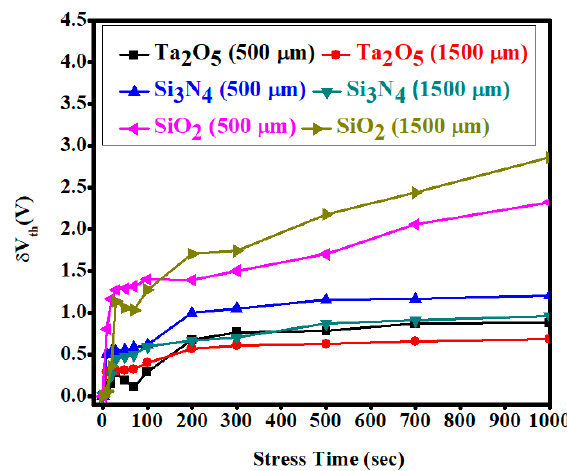
Figure 8. Change of threshold voltage variation under a positive bias stress (PBS) condition for 1000 s using gate dielectric SiO 2 , Si 3 N 4 , and Ta 2 O 5 at different channel widths of 500 µ m and 1500 µ m. The positive stress voltage was +3 V.